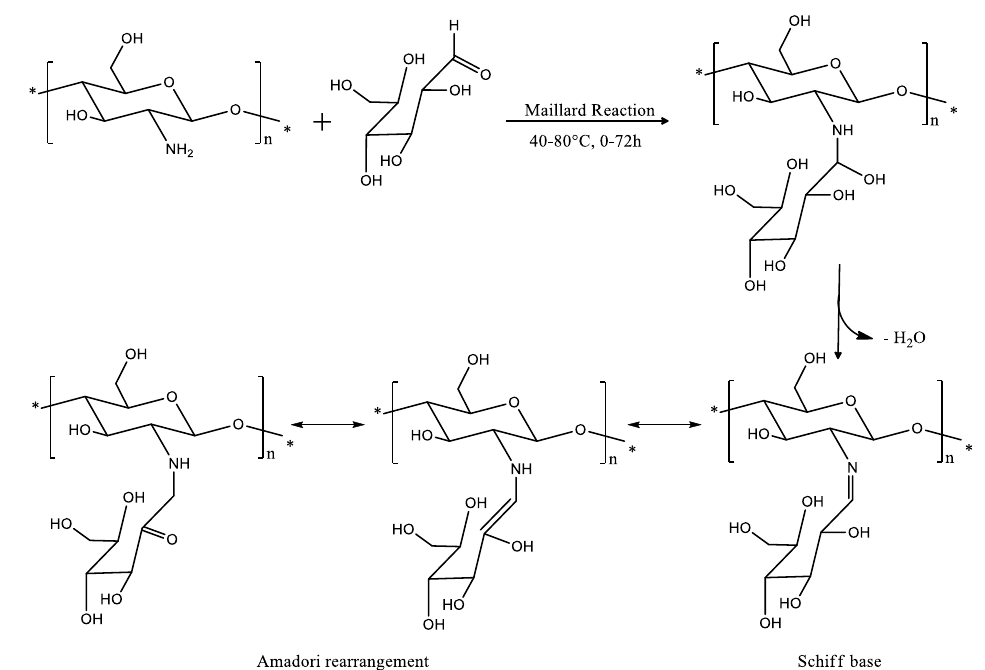
Scheme 3. Mechanism of the Maillard reaction. Redrawn from